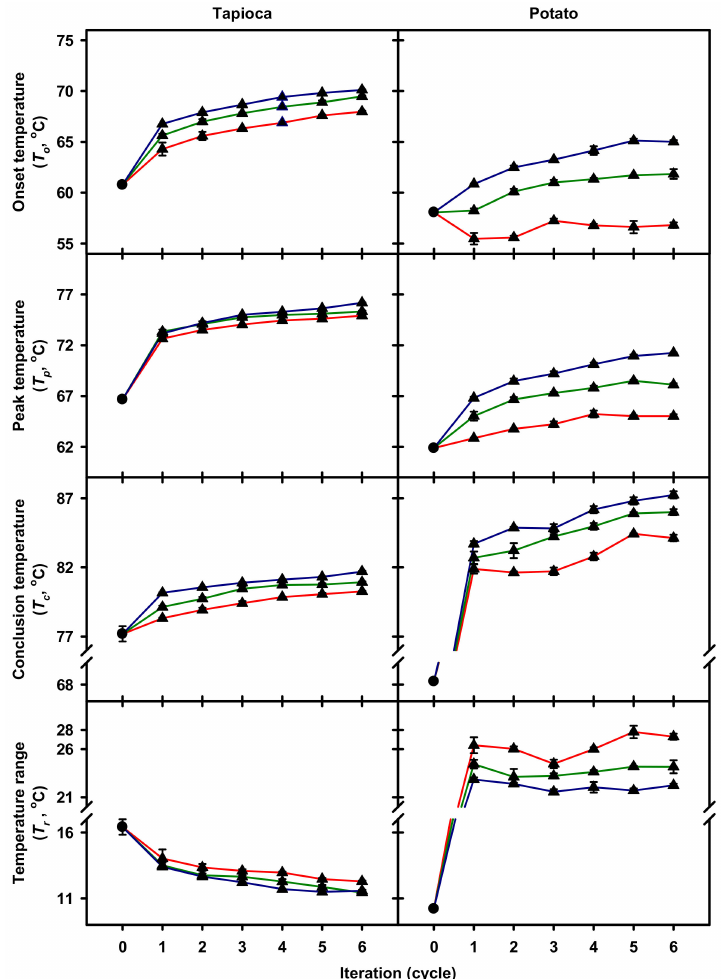
Figure 3. Gelatinization temperatures and temperature ranges of native ( • ) and heat–moisture treated ( (cid:78) ) starches with 0 ( — ), 30 ( — ) or 60 ( — ) min holding time and 1–6 iterations. Analyses were performed in